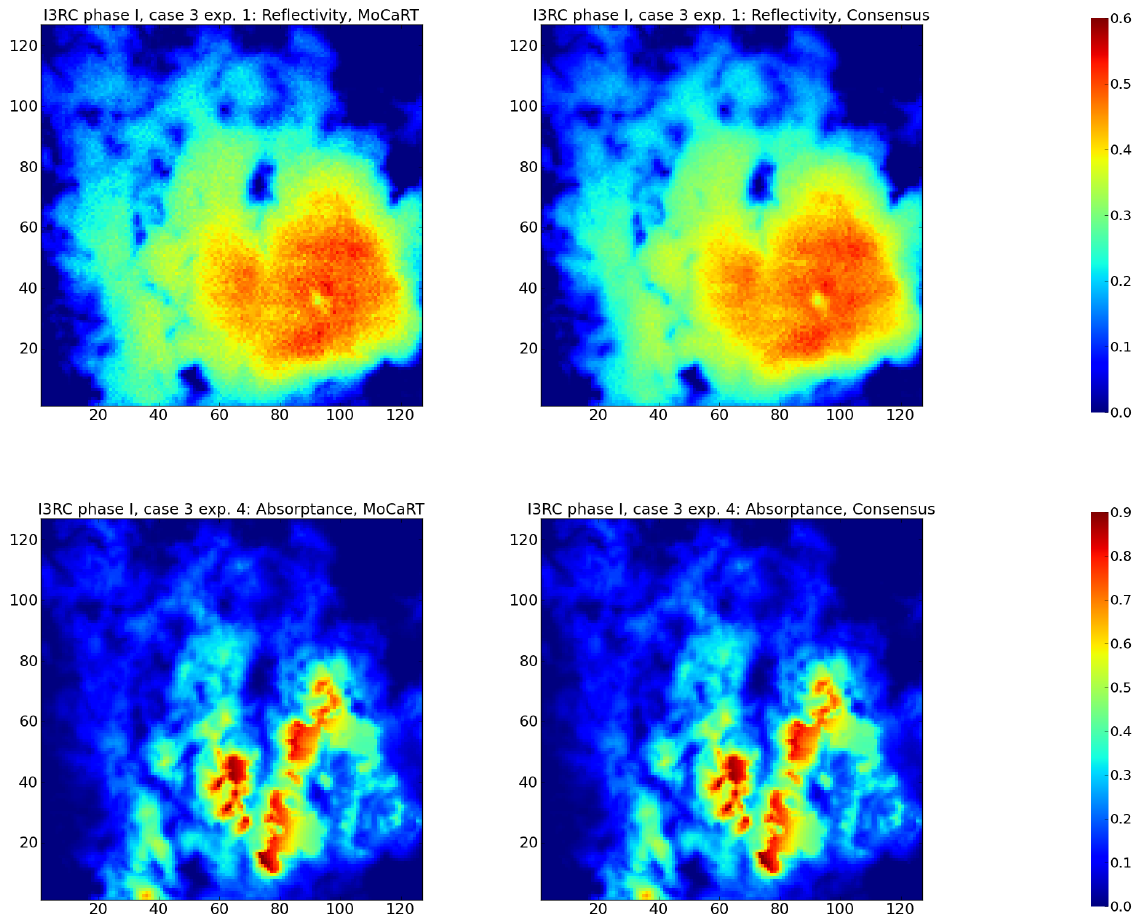
Fig. 2. I3RC project phase I. Case 3 represents a Landsat cloud. MoCaRT results are compared to the consensus results of the participants in I3RC project. The left column shows the MoCaRT and the right column, the consensus results. The top row illustrates the reflectivity fields and the bottom one the absorptance. Differences are well within the Monte Carlo noise.